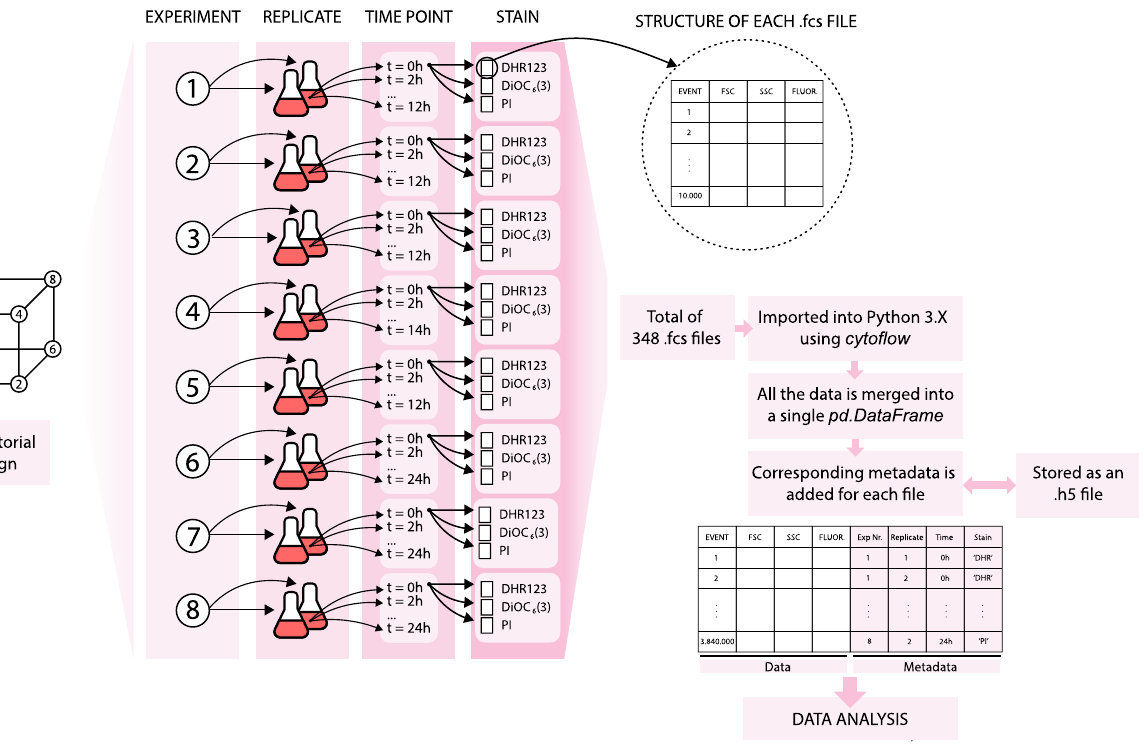
Figure 9. Summary of the experimental design and visualization of the data set